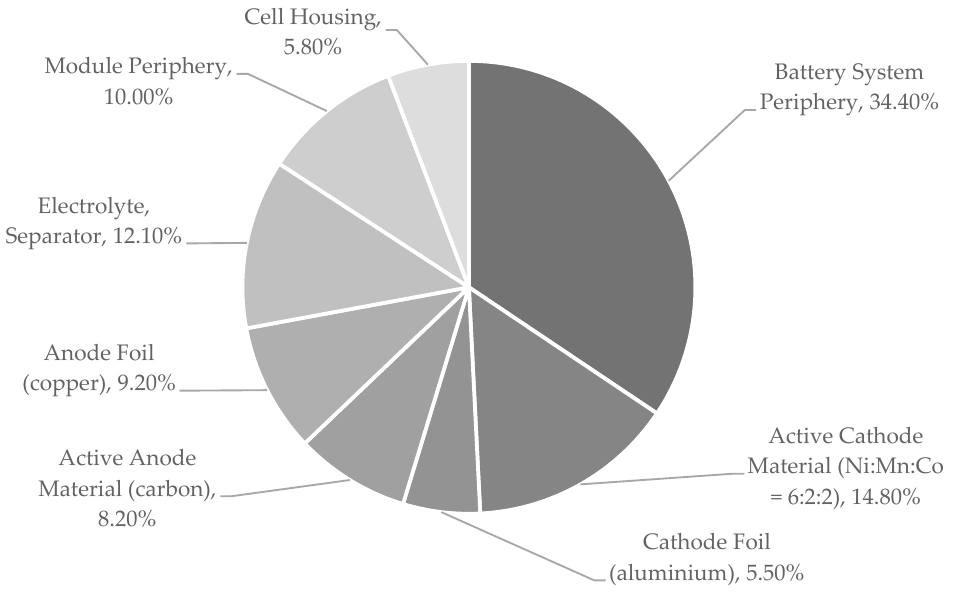
Figure 2. Typical composition of a generic traction battery system based on data from [22].